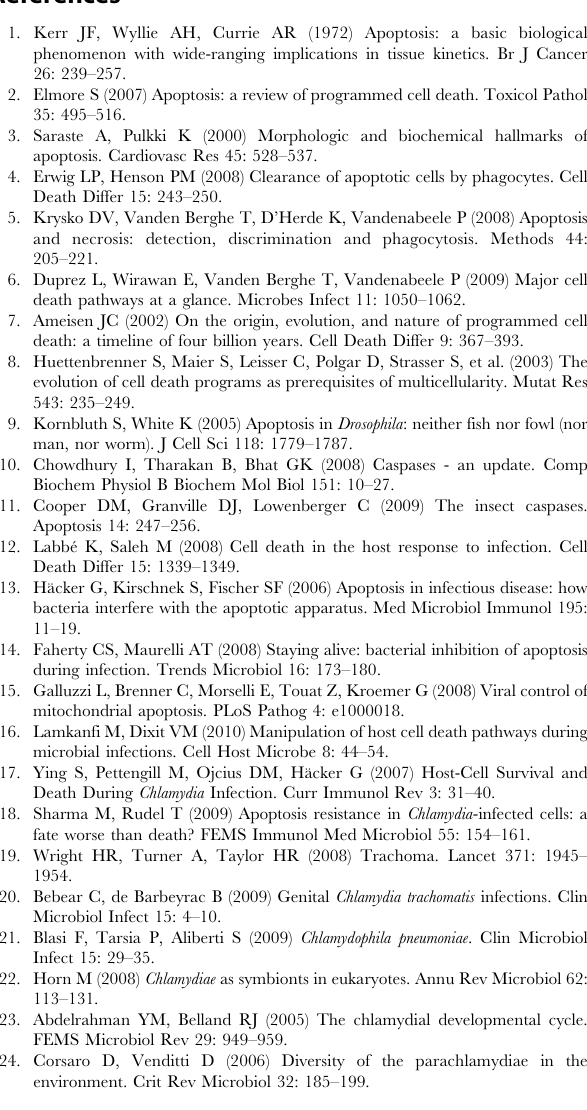
passaged. Figure S9 Transmission electron micrographs of S2 cells infected with Parachlamydiaceae in presence or absence of Z-VAD-FMK. S2 cells were infected with Pa. acanthamoebae or P. amoebophila (MOI 5) and were incubated for 48 h in the absence or presence of the pan caspase inhibitor Z- VAD-FMK (20 m M) before electron microscopic examination (Method S2). Representative images of secondary necrotic cells (observed in the absence of caspase inhibition) and intact infected cells (observed in presence of the caspase inhibitor) are shown. The bar indicates 2 m m. (TIF) Method S1 Detection of internucleosomal DNA frag- mentation on agarose